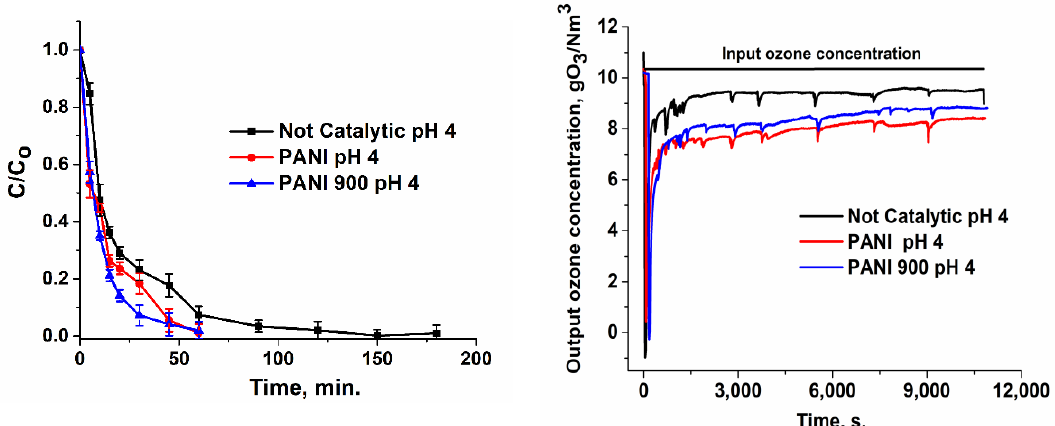
Figure 8. Variation in the normalized ibuprofen concentration and ozone concentration for the catalytic process at pH = 4.